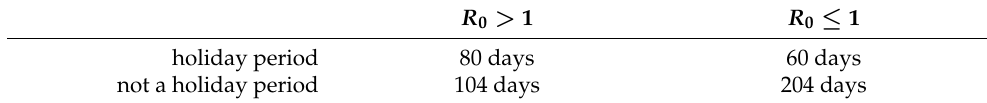
Table 3. Distribution of R 0 value for holidays and non holidays over the period of 448